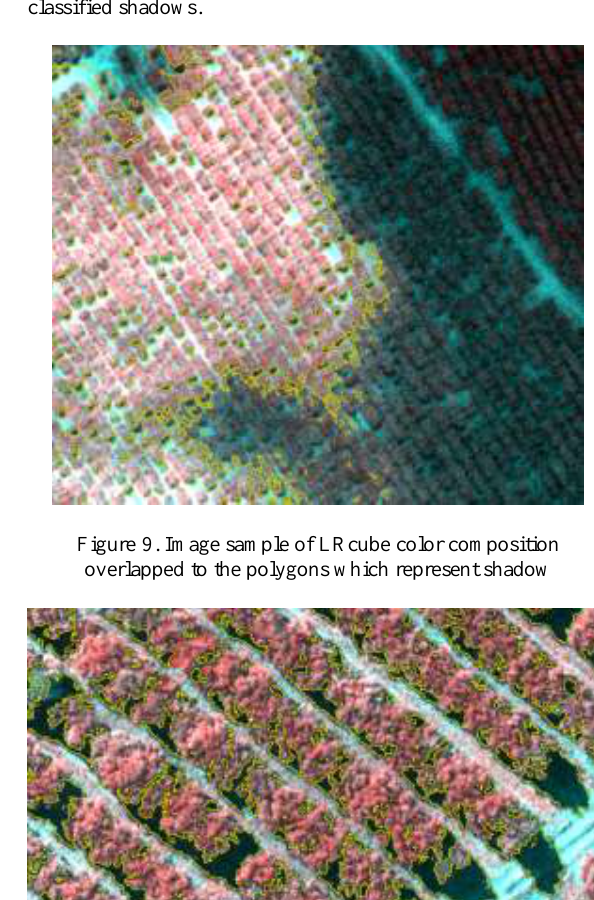
Figure 8. The classification results of two bands of the HRcube where red are pixels of shadows while other colors represent pixels of the no shadow areas. Figure 9 and 10 show segments of LRcube and HRcube color compositions overlapped by the polygons of respective classified shadows.